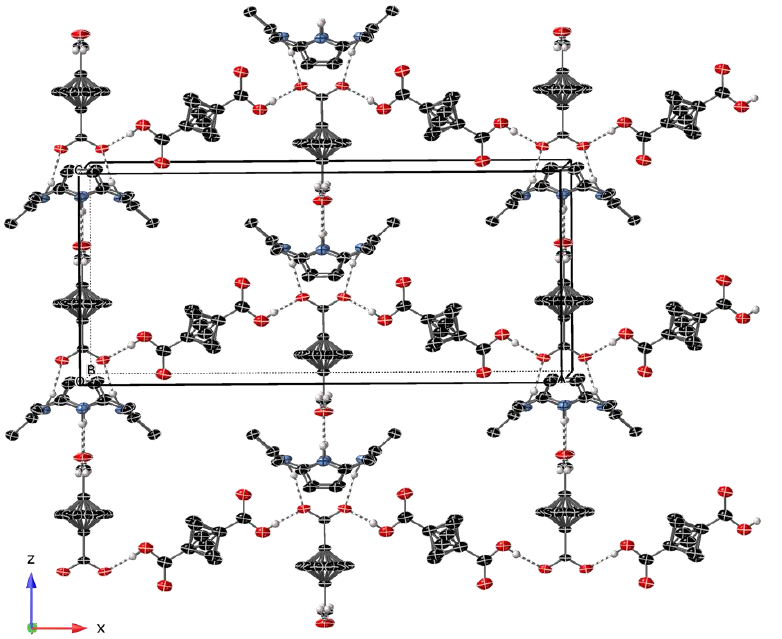
Figure 11. A two- dimensional ‘slice’ of the intricate three -dimensional hydrogen-bonded network of [H 4 OETPP][BCP(CO 2 ) 2 ]·2(BCP(CO 2 H) 2 ).